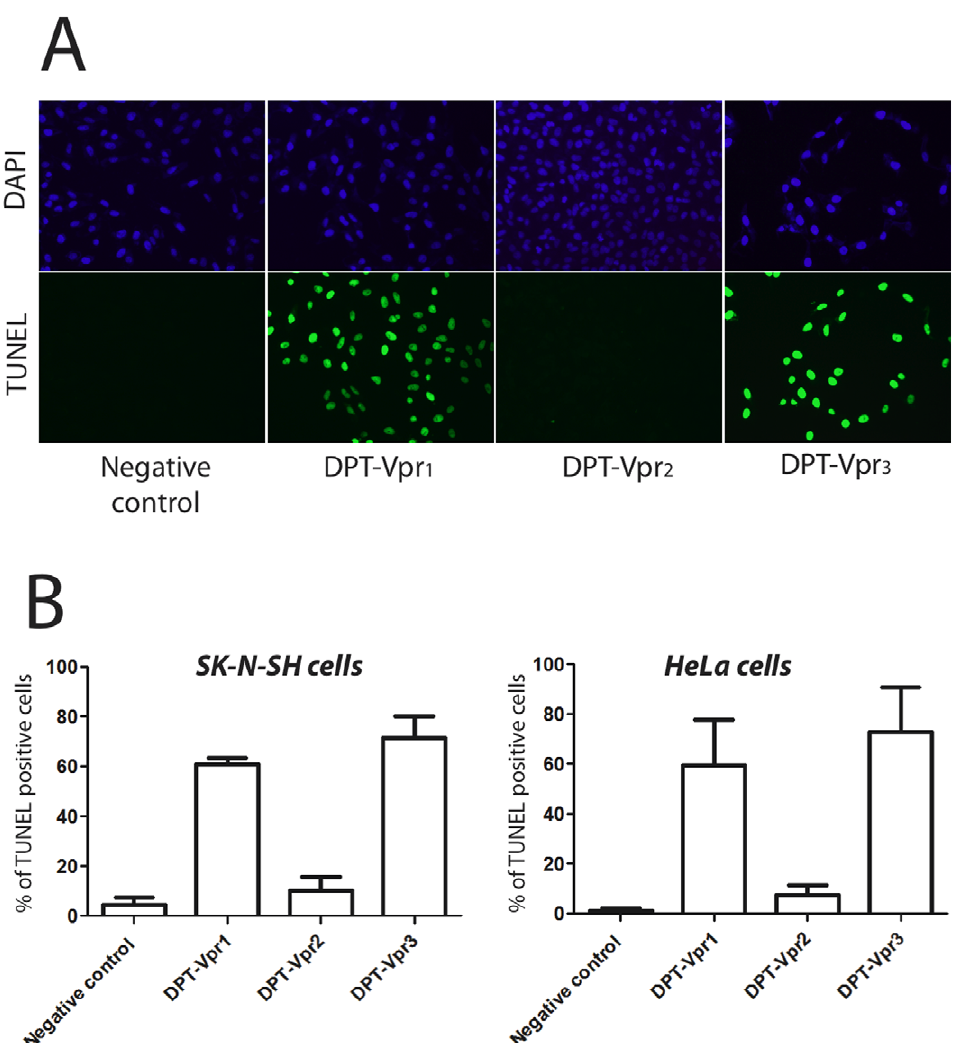
Figure 3. Effect of DPT-Vpr peptides on cell death. (A) Nuclear morphology illustrated with SK-N-SH cells was evaluated with DAPI (blue) and DNA strand breaks were identified using TUNEL labeling (green). (B) Histograms show percentages of positive SK-N-SH cells (left panel) or HeLa cells (right panel) detected in TUNEL assay.